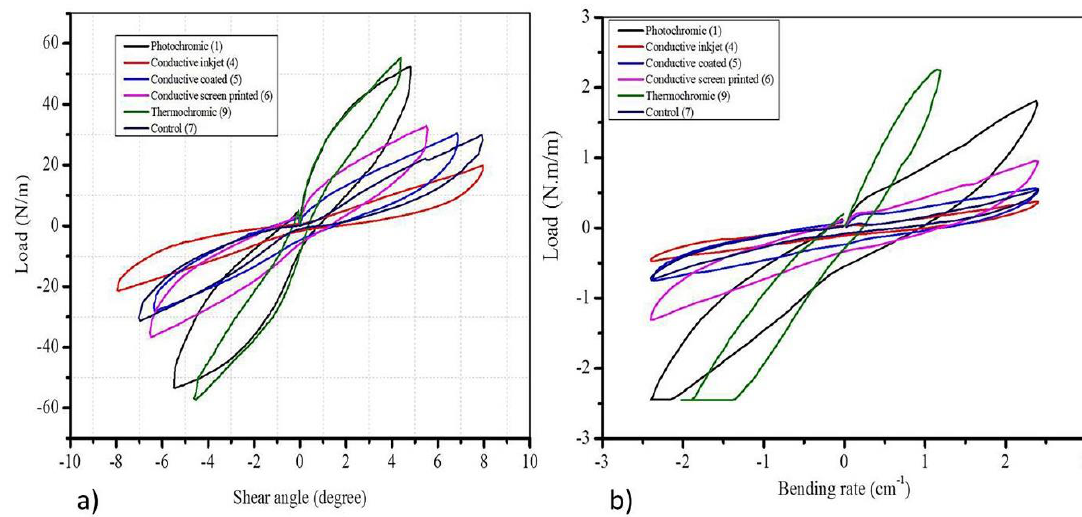
Figure 4. The change in the mechanical characteristics on different functional fabrics under mechanical properties of ( a ) shear and ( b ) bending obtained using KES. The maximum shear angle was 8 degrees. The control sample (7) was used as a substrate and used to produce functional fabrics using different techniques.